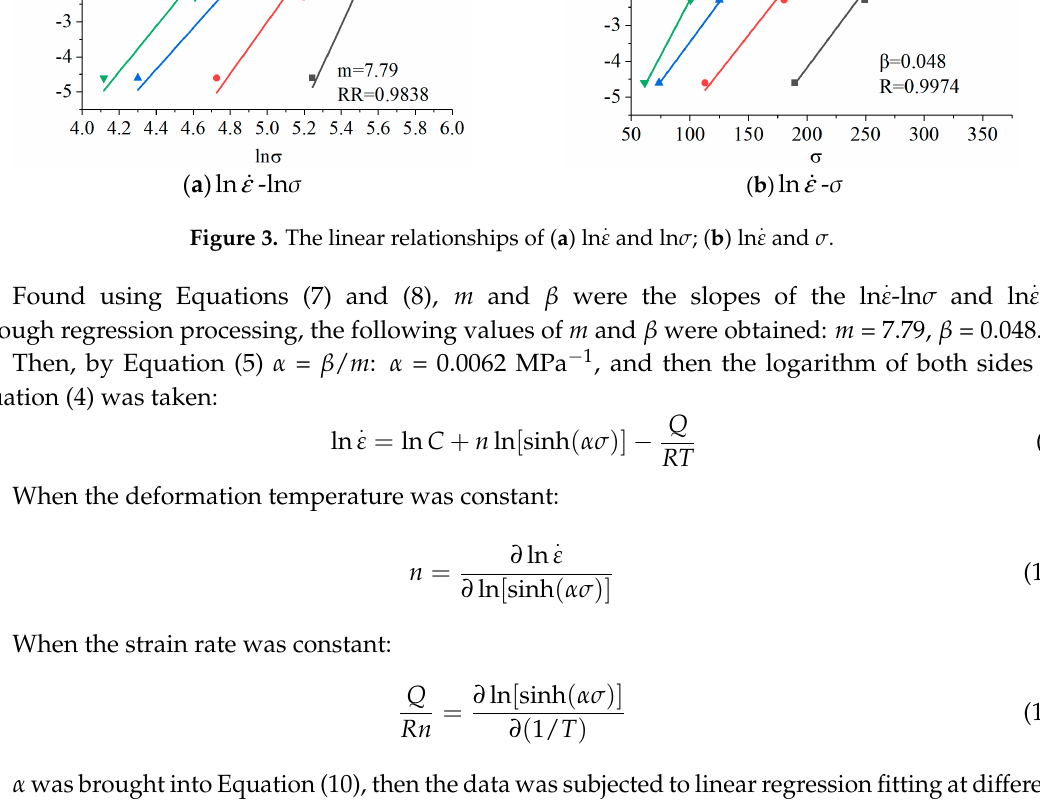
Figure 4. The linear relationships of ln ε and ln[sinh( ασ )].